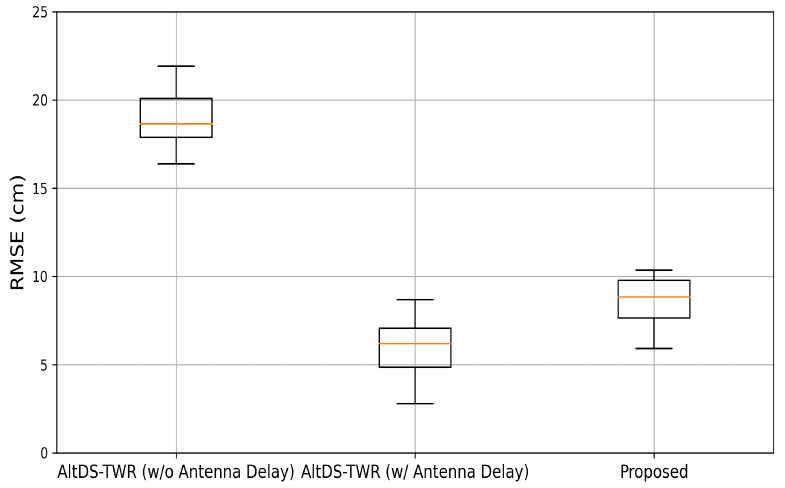
Figure 3. Comparison of RMSEs of the estimated ranges from the three ranging